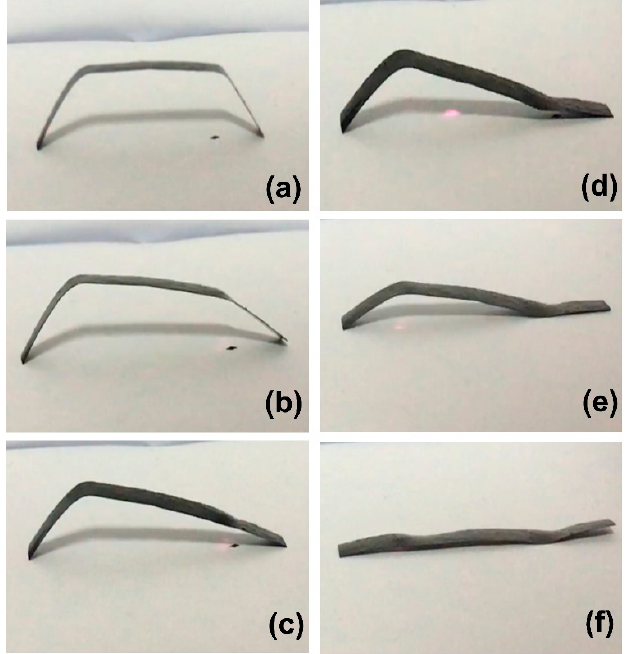
Figure 14. Snapshots of site-selective shape recovery process of MWCNT reinforced V-fa/ECO composite at 0.3 wt% of MWCNTs: ( a ) the deformed “U” shape of the composite, ( b – c ) initial irradiation of the deformed composite with NIR laser at the first crease, ( d – e ) subsequent irradiation of the partially recovered composite with NIR laser at the other crease, and ( f ) the fully recovered original shape of the composite.